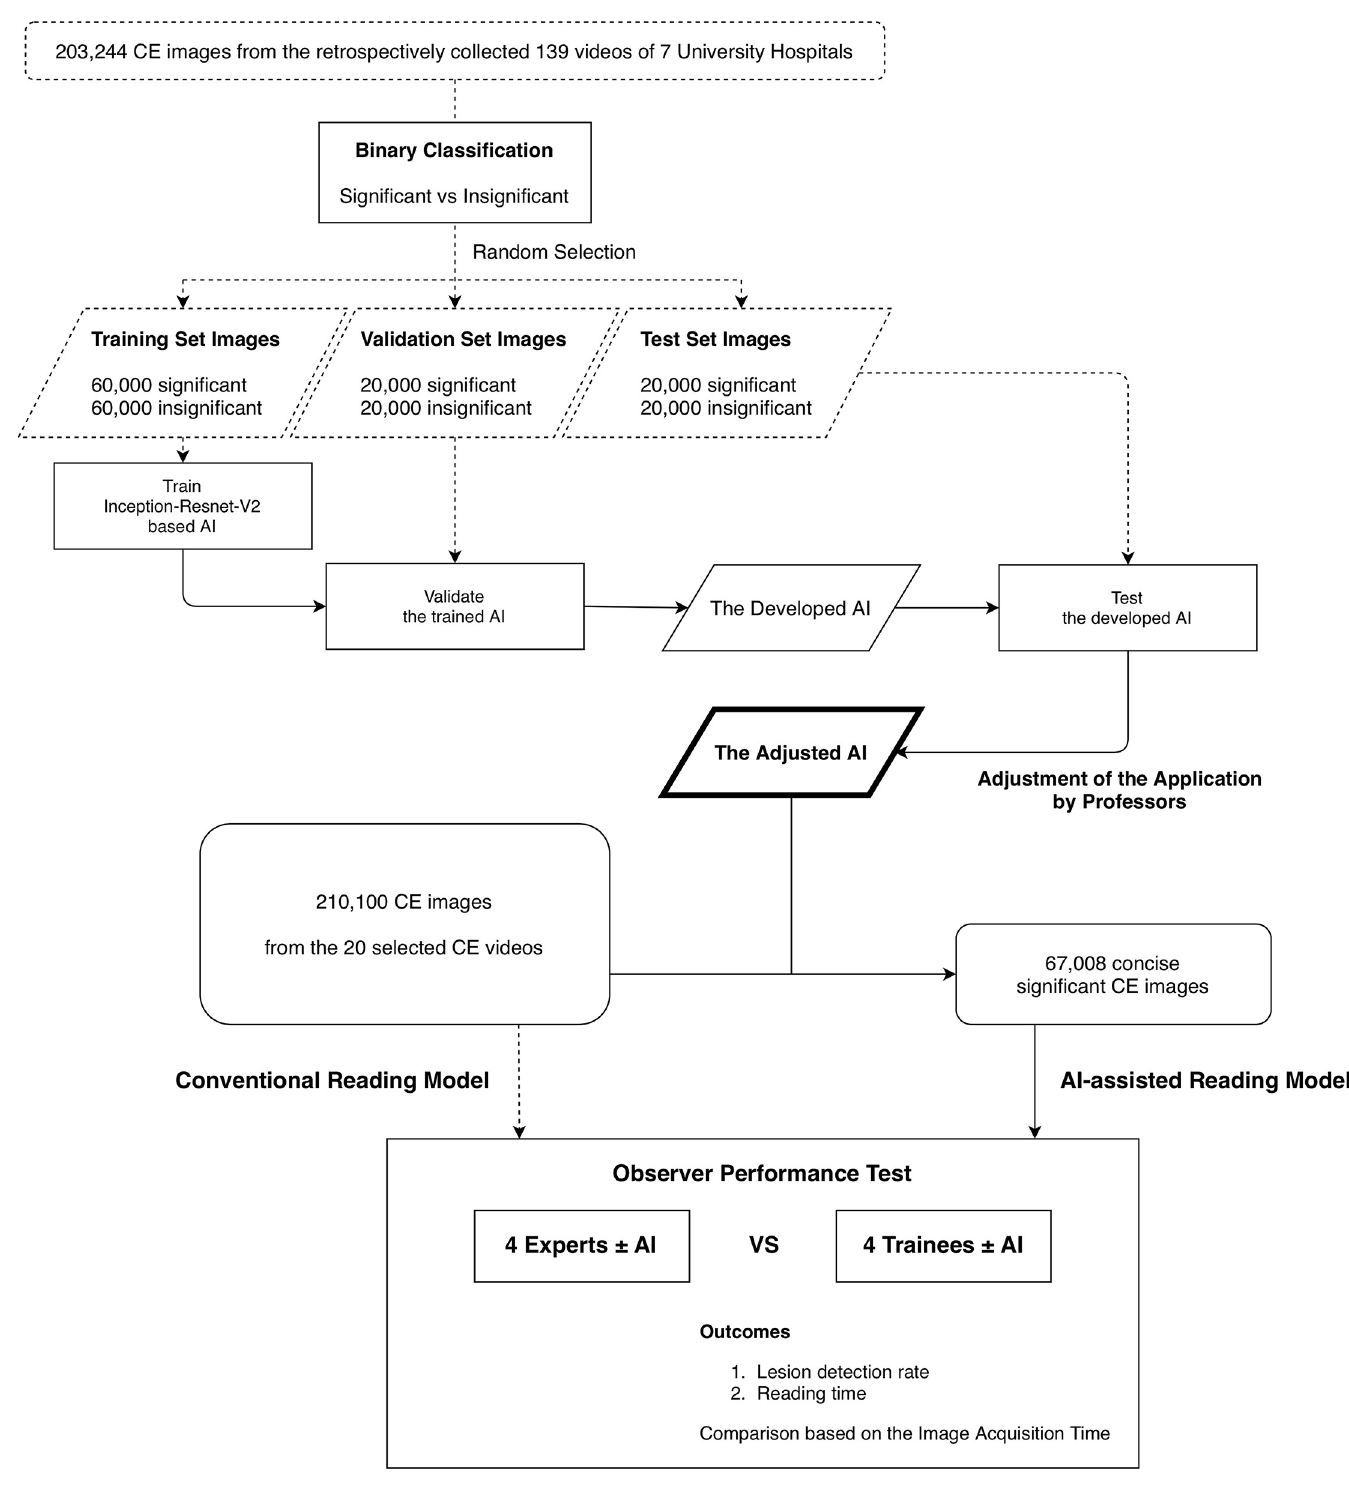
Fig 1. Flowchart of the study design.